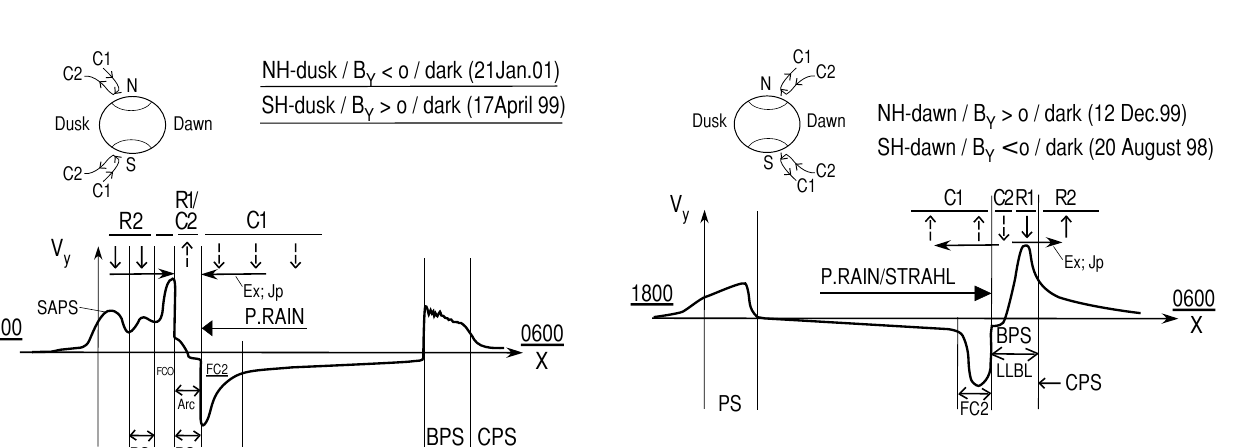
Fig. 27. Schematic illustration of DMSP F13 cross-track ion drift profile along the dusk-dawn meridian in the context of particle pre- cipitation (PS, P.RAIN) and Birkeland current regimes (C1, C2, R1, R2) for event categories NH-dawn/ B y > 0 and SH-dawn/ B y > 0. Not to